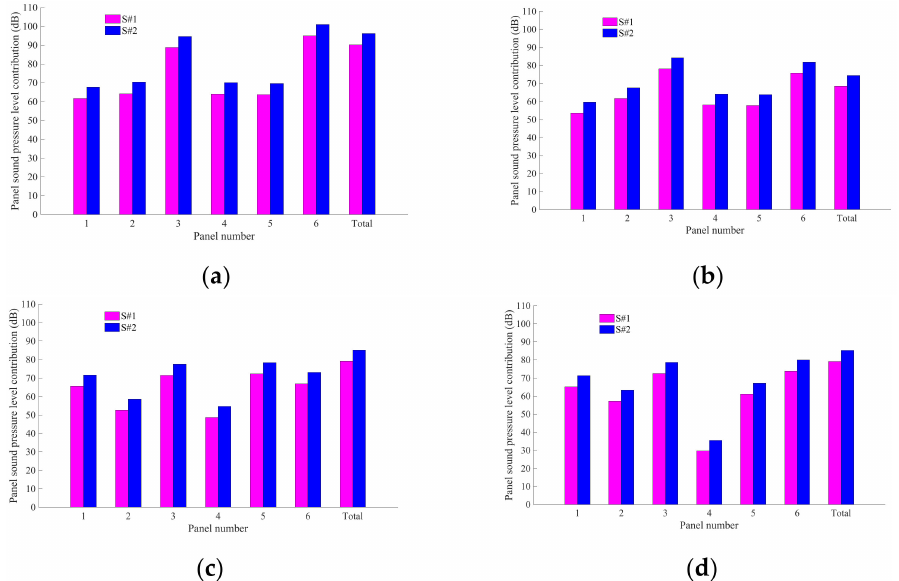
Figure 17. Panel sound pressure level contribution of each field point at 56 Hz; ( a ) field point 1; ( b ) field point 2; ( c ) field point 3; ( d ) field point 4. Table 4. The difference in panel sound pressure level